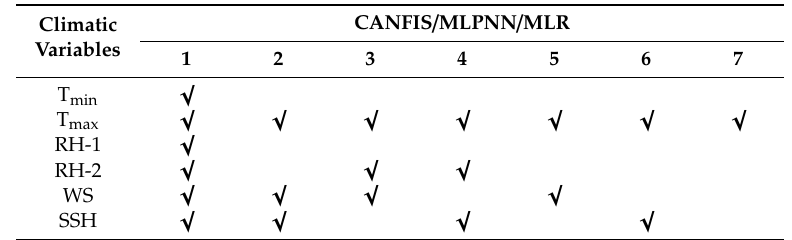
Table 3. Contribution of di ff erent climatic variables to the composition of the seven models at the study stations.